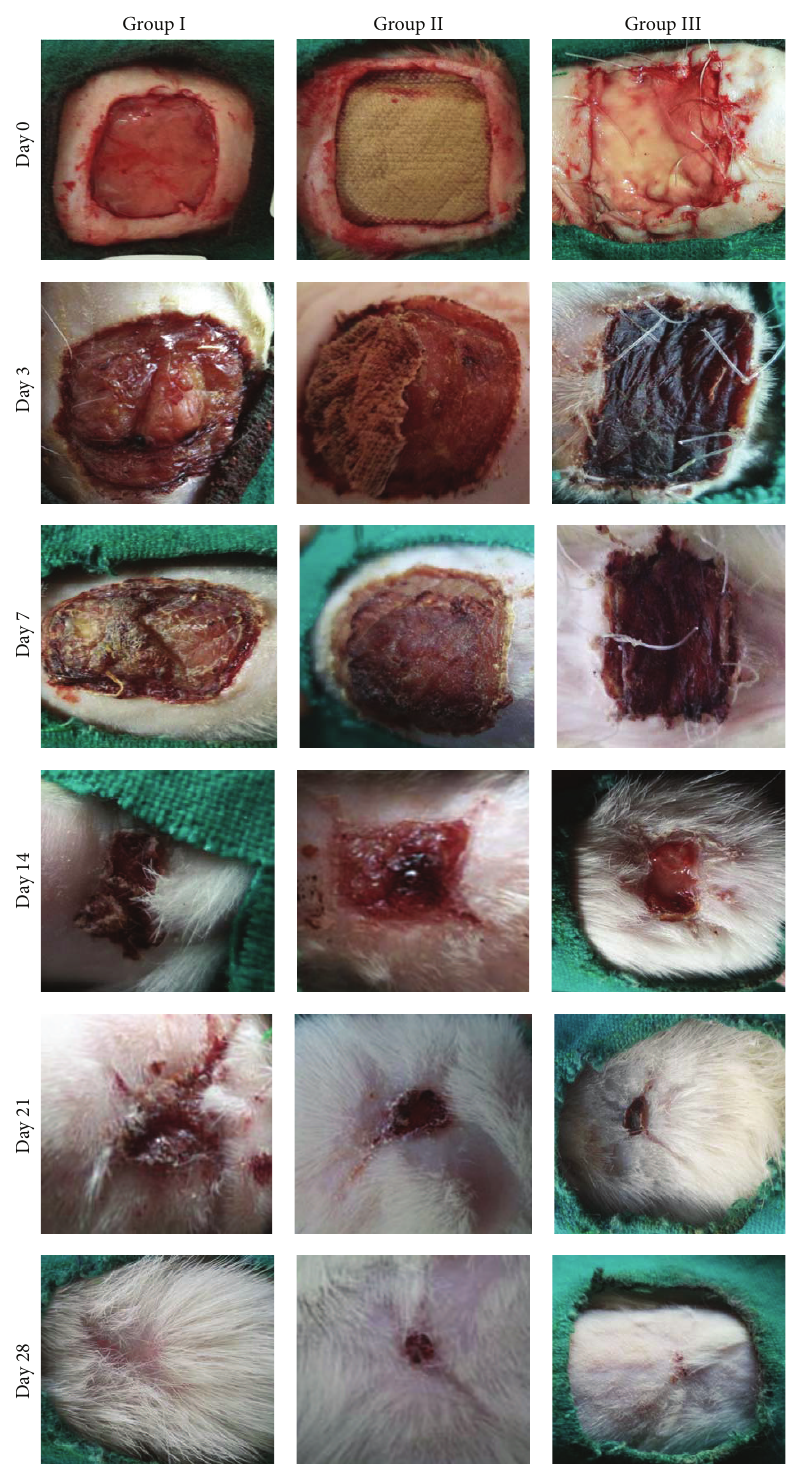
Figure 5: Digital colour photographs of different groups at different time